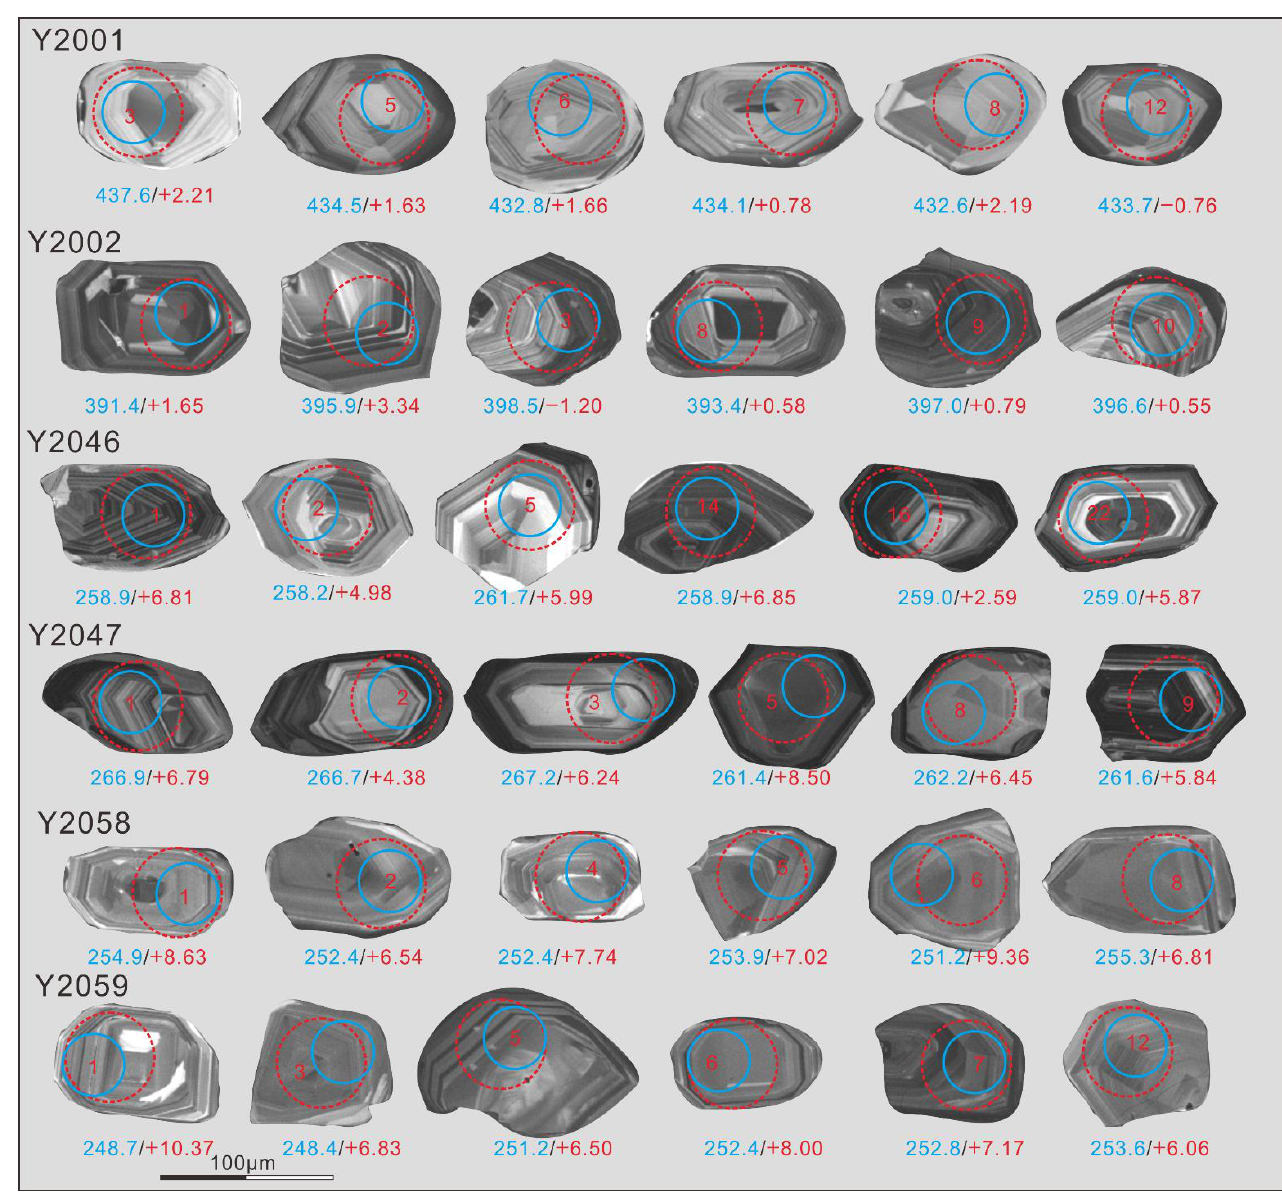
Figure 5. CL images, zircon U – Pb ages (in Ma) and ε Hf(t) isotopic compositions for the analyzed zircon samples. Cyan and red circles represent the locations of U-Pb age and Hf isotope analyses, respectively.